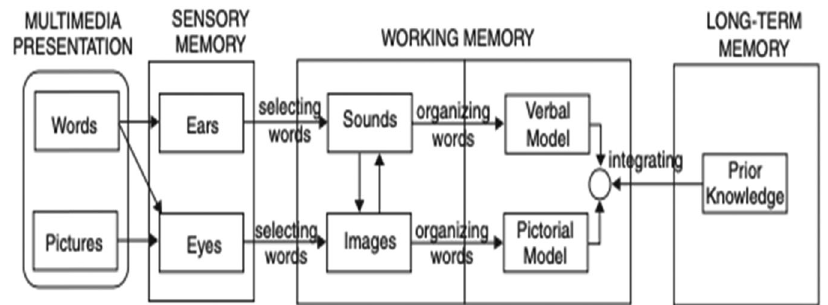
Fig. 1 Mayer ’ s cognitive theory of